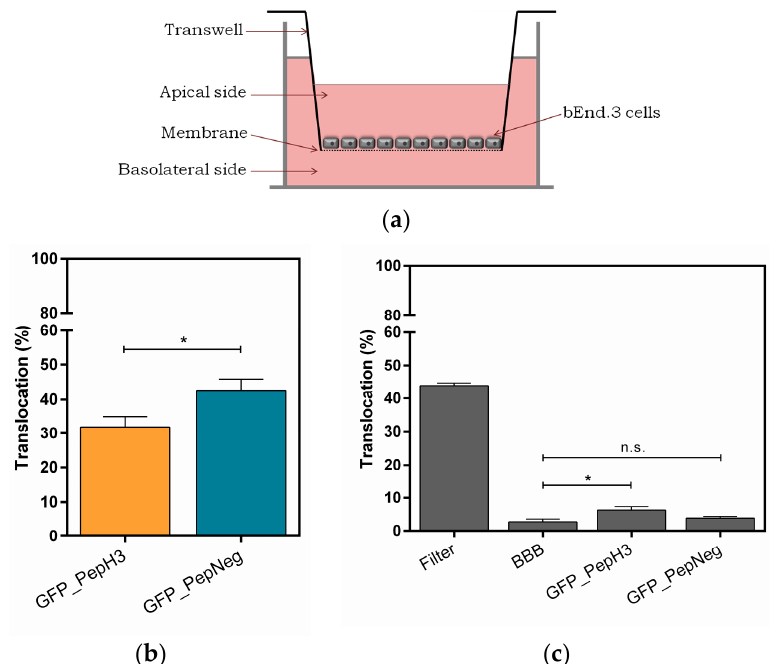
Figure 1. Translocation across a BBB model and the integrity study. ( a ) An in vitro BBB model consisting of an immortalized mouse brain endothelial cell line bEnd.3 grown as a monolayer on the apical side of the tissue culture insert; ( b ) Percentage of translocation determined by GFP fluorescence intensity measurements, for 0.1 μ M of GFP_PepH3 (orange) and GFP_PepNeg (blue). A one-way ANOVA statistical test followed by a Dunnett’s test was used to compare both fluorescence measurements obtained (* p ≤ 0.05); ( c ) Percentage of FD40 permeability after exposure to GFP_peptide (for 5 h). The recorded percentages were compared to two controls: one with the transwell without cells (“Filter”) and the other consisting of the BBB model without GFP_peptide incubation (“BBB”). The statistical test used to compare each fluorescence measurement with the BBB fluorescence obtained was a one-way ANOVA followed by a Dunnett’s test (* p ≤ 0.05; n.s., not significant). The values were obtained from duplicates of three independent experiments.